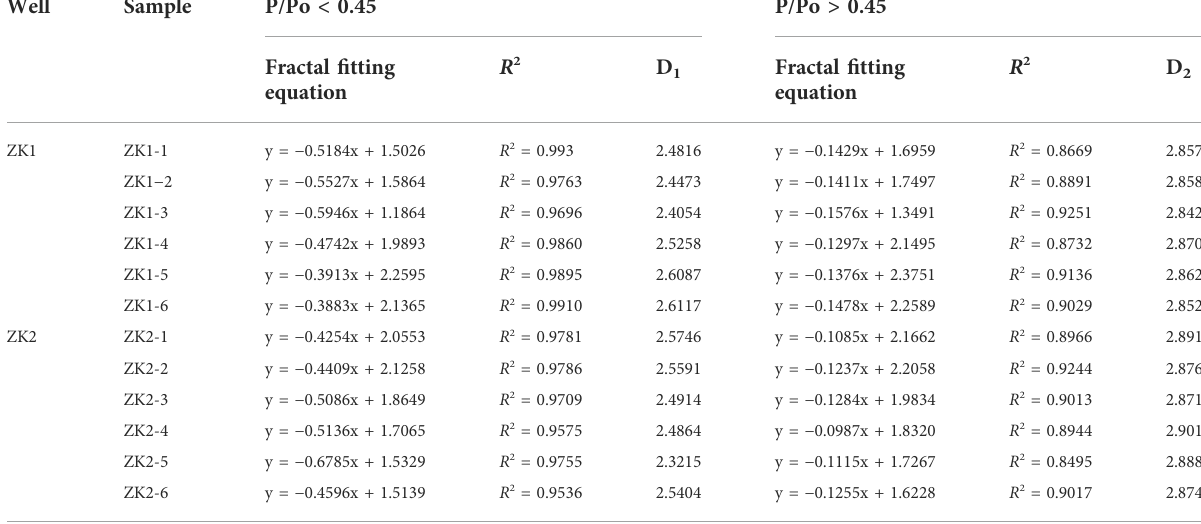
TABLE 2 Fractal dimension of the Wufeng-Longmaxi Formation shale based on the FHH theoretical model. Well